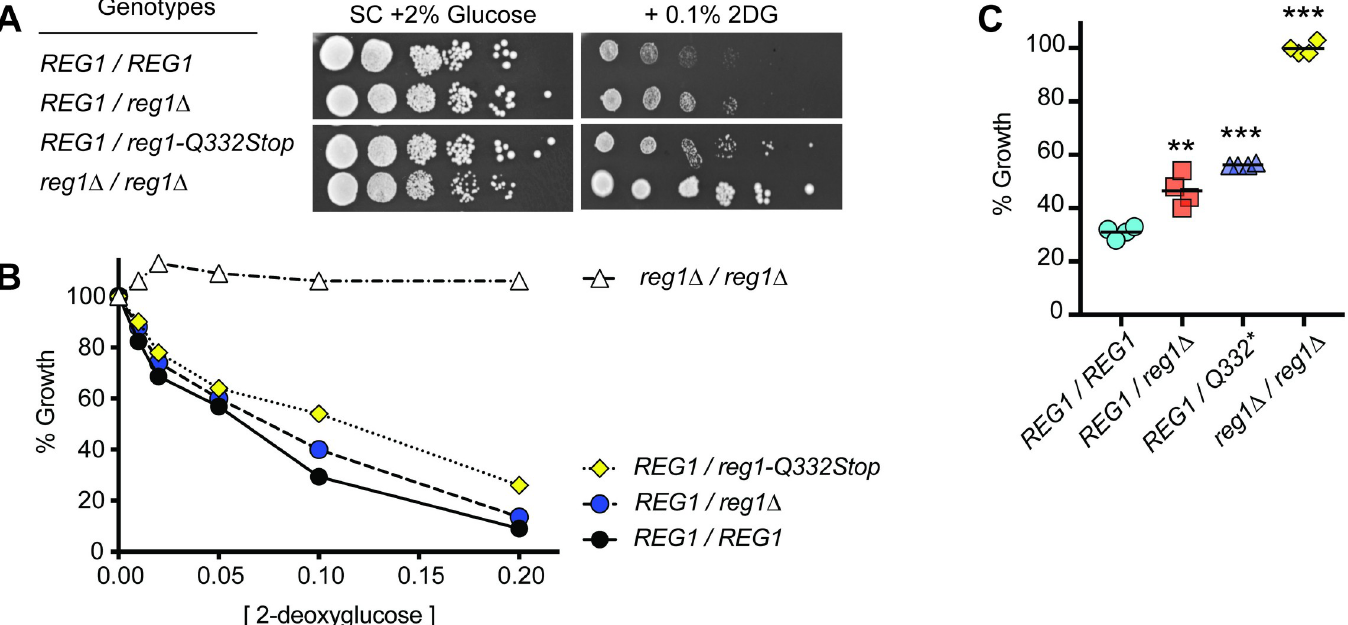
Fig 3. Haploinsufficiency of REG1 confers 2DG resistance. A. Diploid cells with the indicated genotypes at the REG1 locus were serially diluted and spotted onto agar plates containing SC medium with 2% glucose with and without 0.1% 2DG. B. 2DG resistance assay of diploid cells with the indicated genotypes. C. 2DG resistance measured in quadruplicate using 0.1% 2DG. Diploid strains used in this experiment were as follows: REG1/REG1 (MSY1333 x MSY188); reg1 Δ /REG1 (MSY1333 x MSY930); reg1-Q332Stop/REG1 (MSY188 x MSY1520); reg1 Δ /reg1 Δ (MSY930 x MSY841).